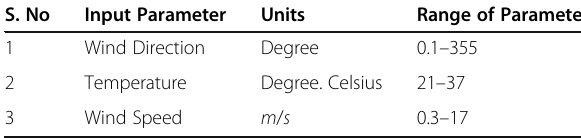
Table 2 Inputs parameters for RRBFNN